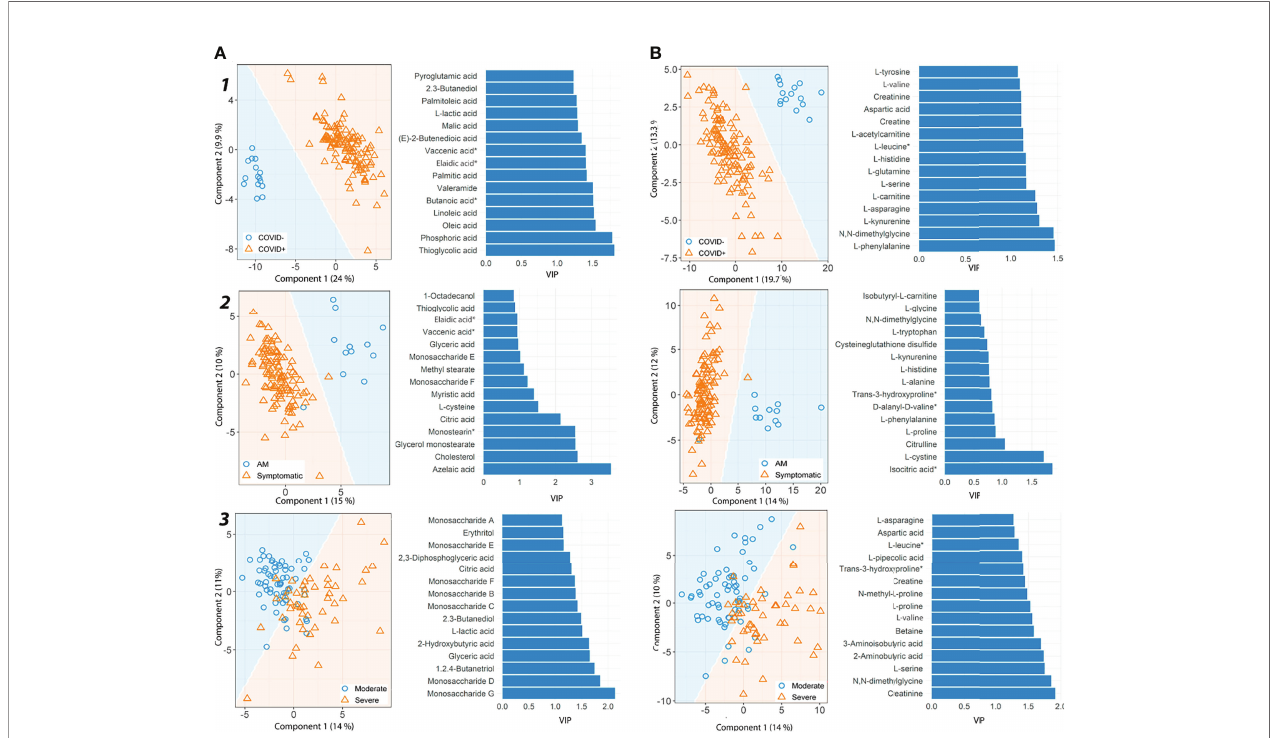
FIGURE 1 | Partial least square discriminant analysis (PLS-DA) results for metabolites detected by GC-MS and CE-MS. (A) GC-MS metabolites, (B) CE-MS metabolites. For each group pairwise comparison, two different results are shown, prediction area visualization through the Mahalanobis distance and the fi rst fi fteen variable importance projections (VIP) scores. Each analysis is shown for different pairs of patient groups. 1 ) COVID+ patients vs. healthy controls. 2 ) Asymptomatic/ Mild patients (AM) vs. Symptomatic patients and 3 ) Severe vs. Moderate patients. AM, Asymptomatic/Mild patients. Vaccenic acid, (E)-11-Octadecenoic acid. Elaidic acid, (E)-Oleic acid. Butanoic acid*, Butanoic acid. 2-(methoxyimino)-3-methyl-. trimethylsilyl ester. Monostearin*, Monostearin/1-stearoyl-rac-glycerol. L-leucine*, L- Leucine/Isoleucine. Trans-3-hydroxyproline*,